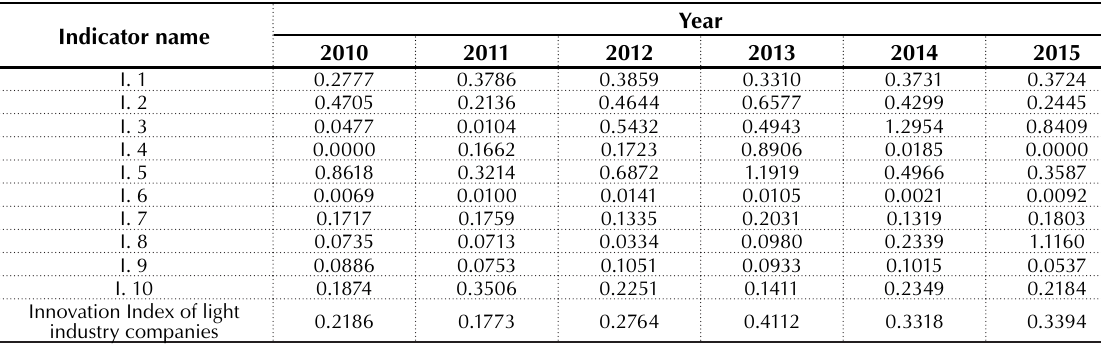
Source: The calculations are based on the data of Table 1.